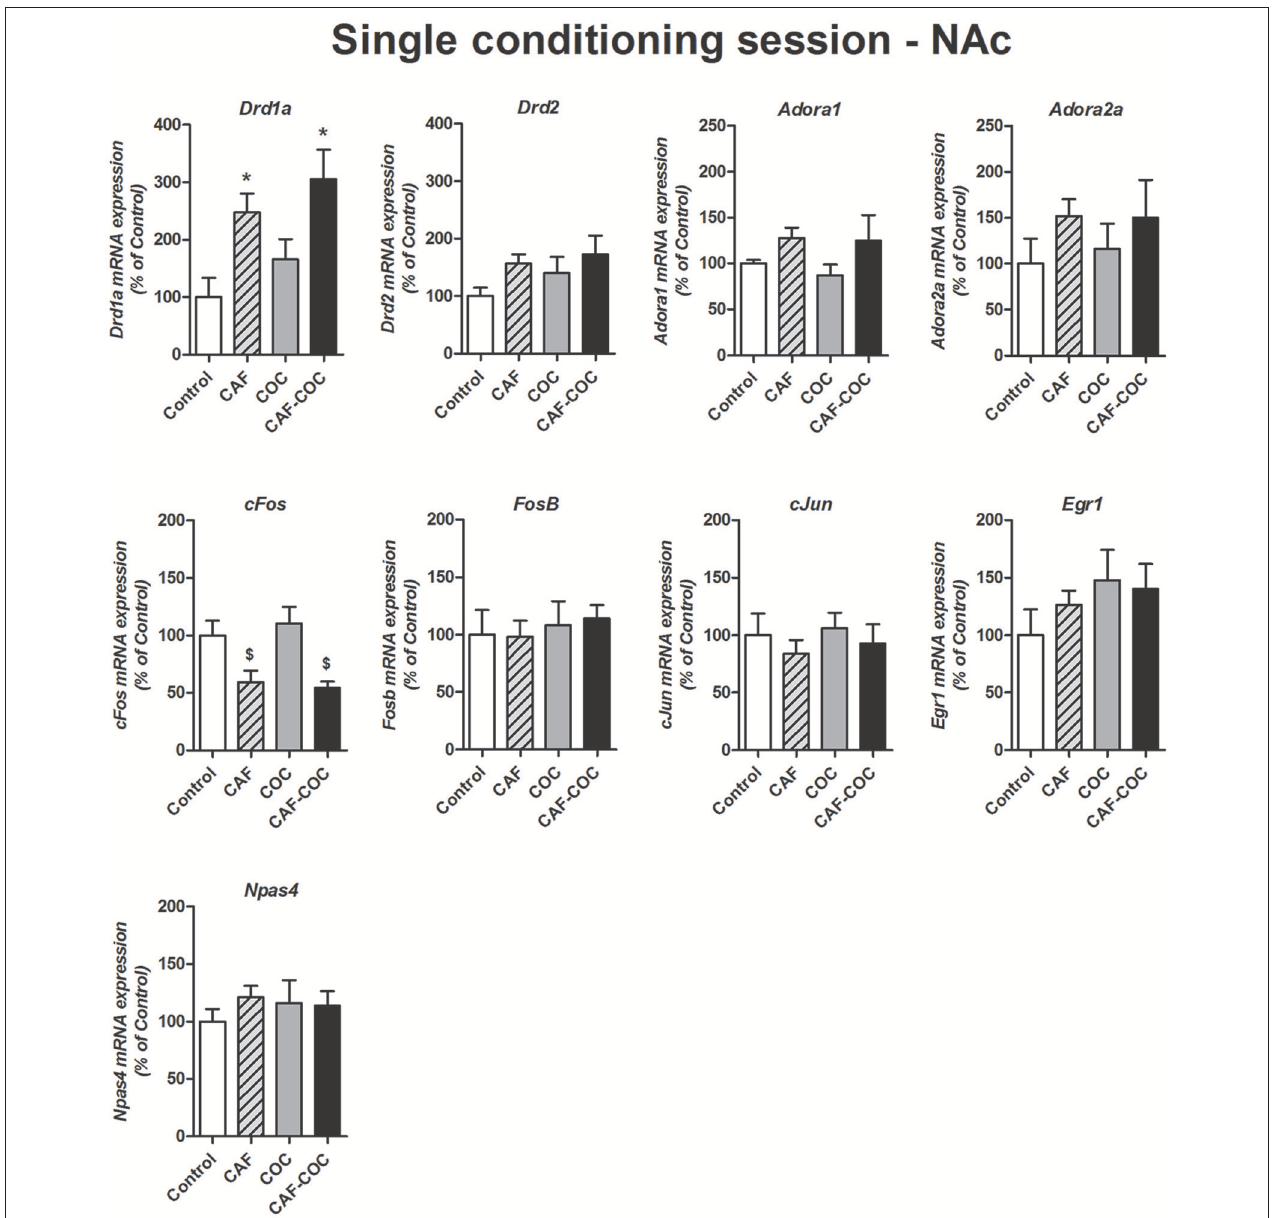
FIGURE 6 | Gene expression changes in the NAc following a single conditioning session of the CPP. Dopamine receptor subunits Drd1a and Drd2 ; adenosine receptor subunits Adora1 and Adora2a ; IEGs FosB , cFos , cJun , Egr1 , Npas4 . Values indicate mean ± SEM. One-way ANOVA–Tukey: * p < 0.05 different from Control, $ p < 0.05 different from